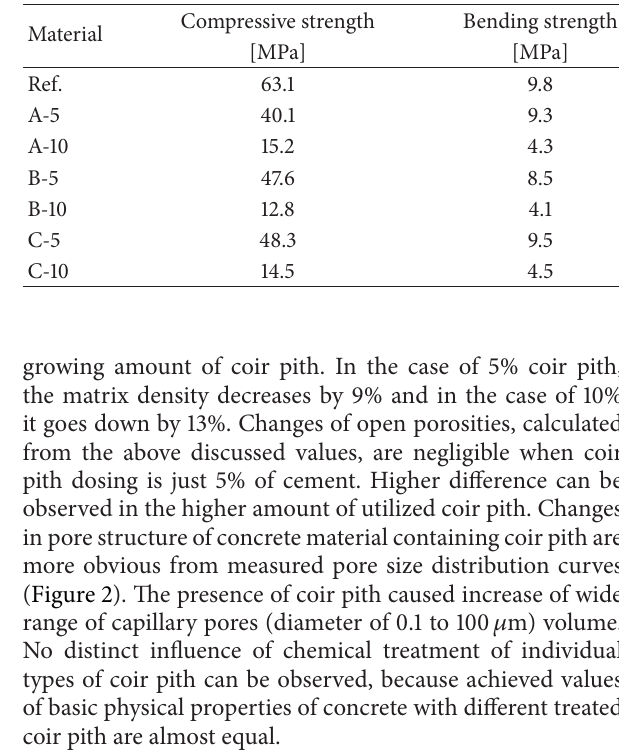
Table 7: Mechanical